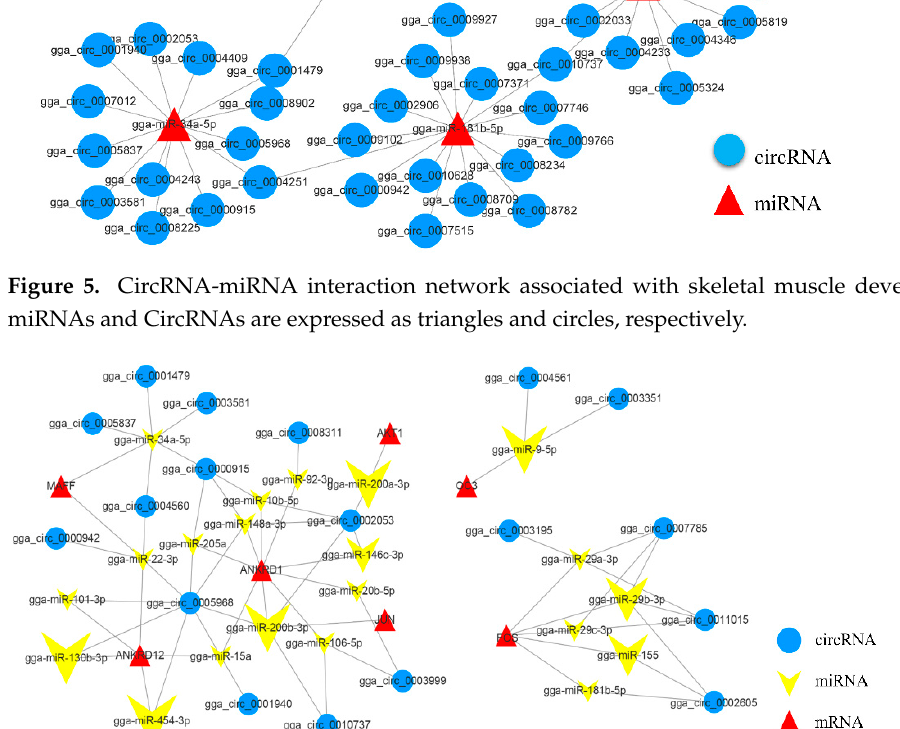
Figure 7. CircRNA ‐ miRNA ‐ gene interaction network related to cell growth. The circle, inverted ar ‐ rows, and triangles represent circRNAs, miRNAs, and mRNAs, respectively. 3.6. Internal Ribosome Entry Site (IRES) Prediction of circRNAs In this study, we found that 1295 circRNAs had IRES elements on their sequences, accounting for 61.32% of the predicted and analyzed circRNAs. We counted the interval distribution of the prediction scores of these circRNAs (Supplementary Figure S3). The